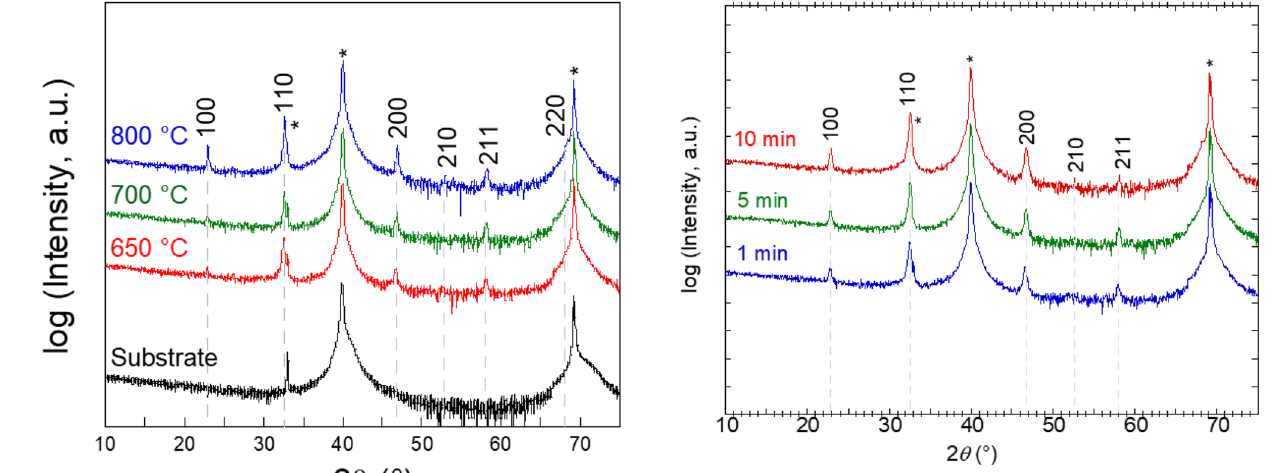
Fig. 1 Reference XRD scan of a substrate with no film deposited and scans of 210 nm films annealed at 650, 700 and 800 °C with present BNKT peaks labeled (Substrate peaks are marked by a * symbol)